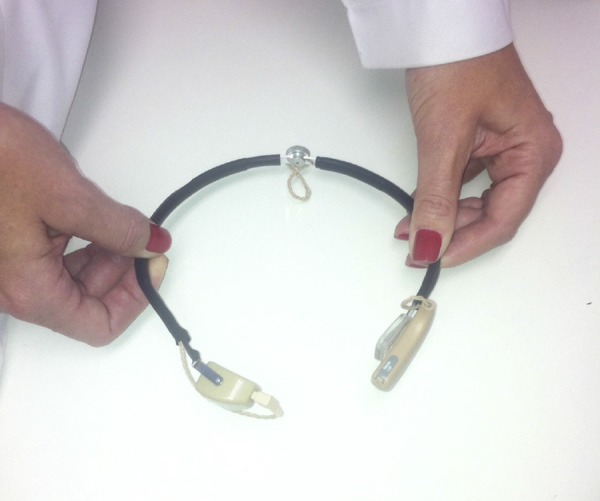
Type of prosthesis.